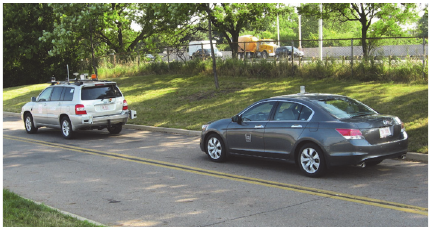
Figure 4: OSU CITR vehicles in a convoy. The vehicle on the right was instrumented with a number of sensors and driven by study participants.